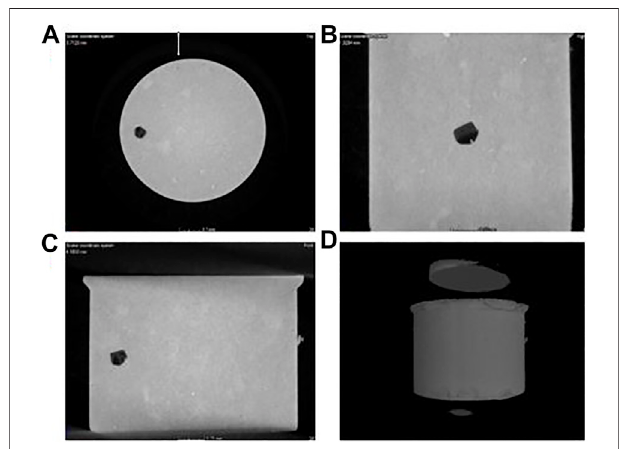
FIGURE 1 | An X-CT image of a powder press sample before CLSM melting: (A) top view of the sample showing the position of the inclusion, (B) side view of the sample showing the position of the inclusion, (C) another side view of the sample showing the position of the inclusion, (D) 3D volume of the powder pressed pellet where the inclusion is the darker area, and light grey is steel.